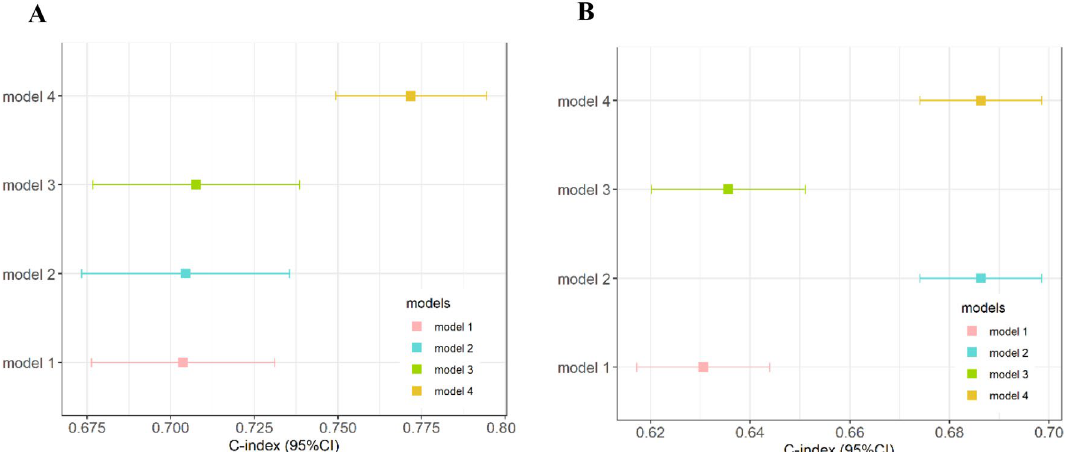
Figure 2. C-index of the prediction models. ( A ): Training cohort; ( B ): Testing cohort; model 1, Cox-TNM; model 2, Lasso-Cox; model 3, RSF-TNM; model 4, RSF.